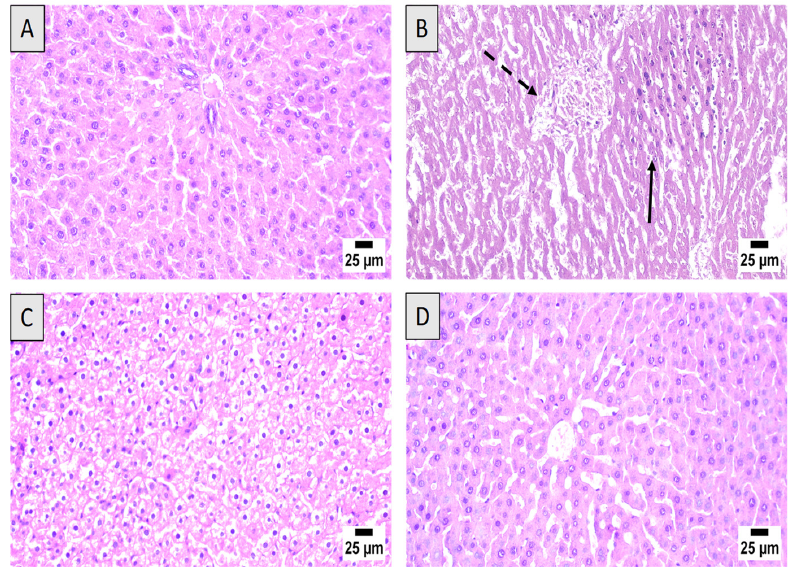
Figure 4. Histological examination of hematoxylin-eosin sections of rat livers. ( A ) Control group showing normal histoarchitecture of the liver tissues. ( B ) DOX-alone treated group with widespread hepatocellular necrosis (dashed arrow) and inflammatory cells infiltration (regular arrow). ( C ) DOX + ML (15 mg/kg) treated group exhibiting diffuse vacuolar degeneration of hepatocytes with limited necrotic areas. ( D ) DOX + ML (30 mg/kg) treated group showing apparently almost normal hepatic parenchyma.